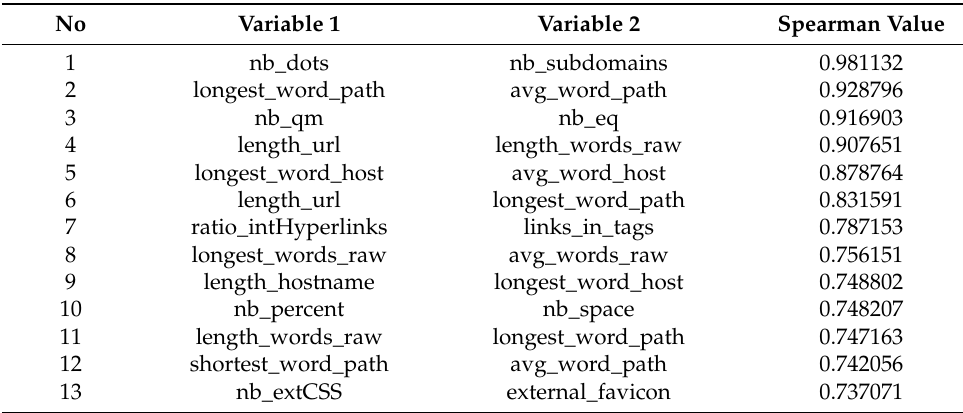
Table 12. Spearman correlation value between features on Dataset